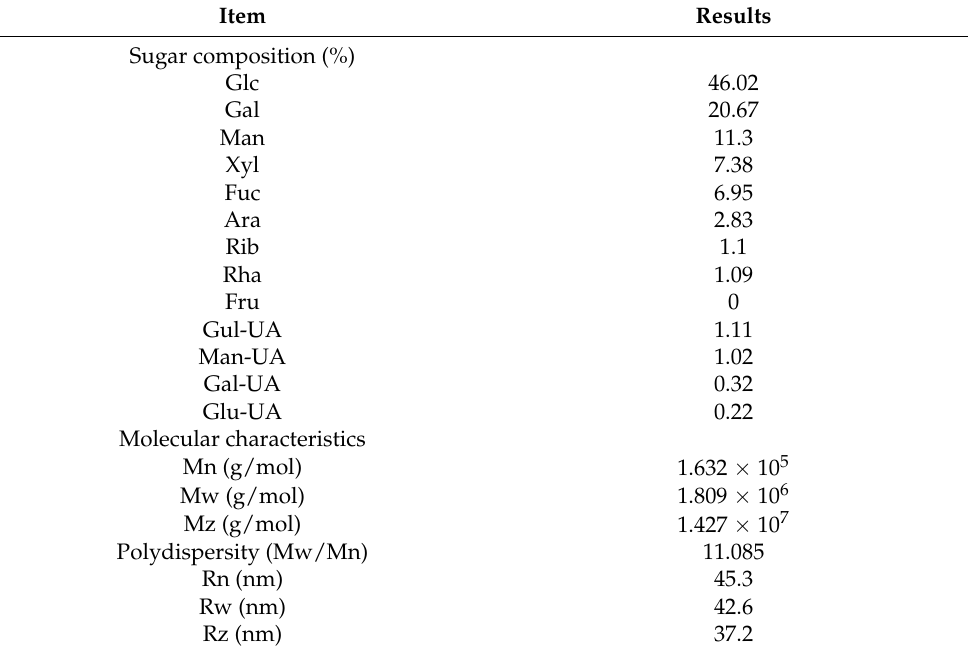
Table 1. Characteristics of polysaccharides extracted from FV